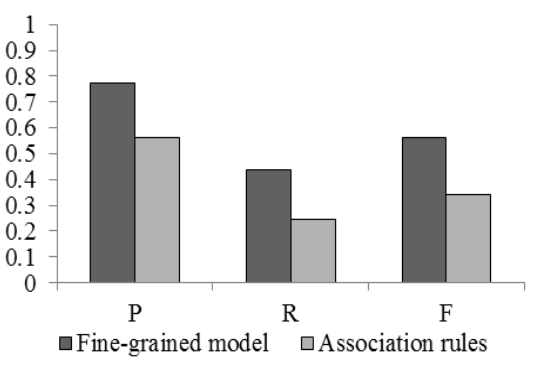
Fig. 4. Emotional element detection result comparison on micro-blog